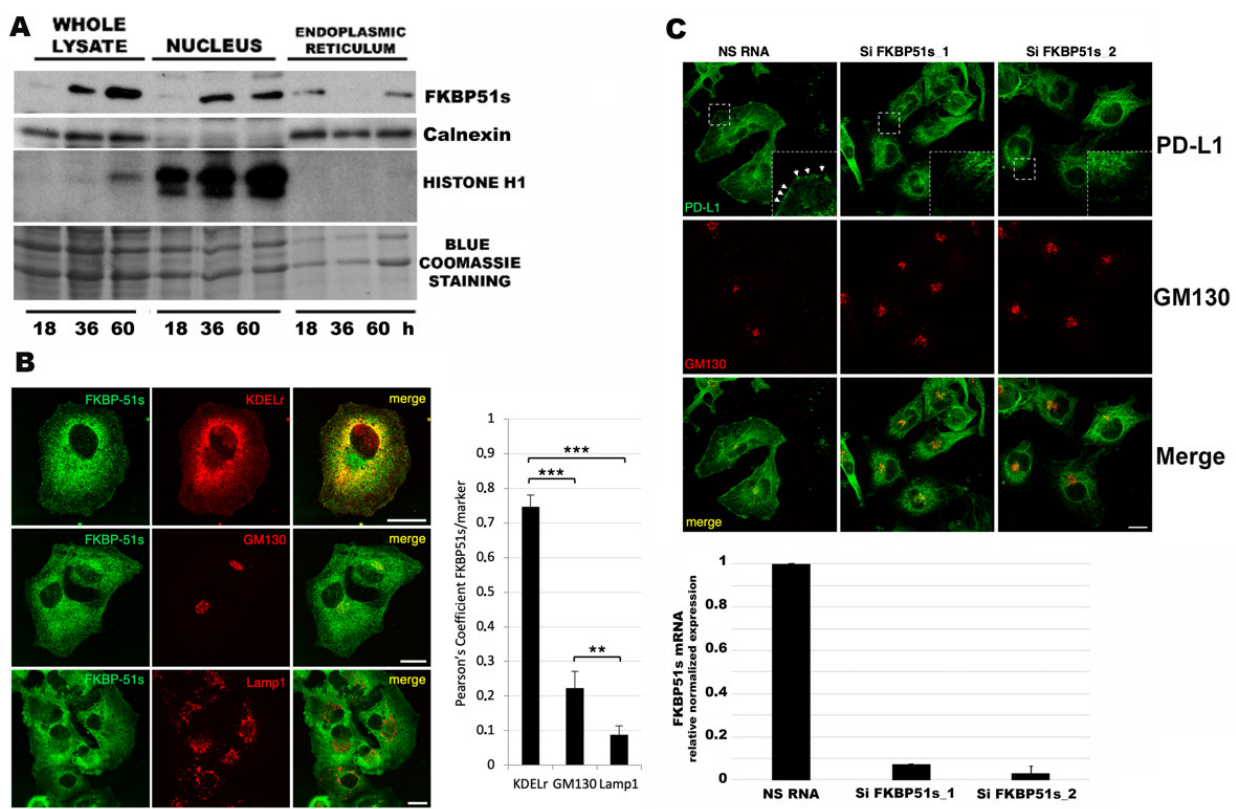
Figure 3. FKBP51s cellular distribution. ( A ) Western blot assay of total and fractionated (ER, nucleus) U251MG cell lysates. FKBP51s levels are shown along with relative organelle markers (calnexin, histone H1, for ER and nucleus, respectively) as loading controls. ( B ) Confocal microscopy: U251MG cells were seeded on coverslips and after 24 h were processed for indirect immunofluorescence by using specific antibodies against FKBP51s, KDEL receptor (ER marker), GM130 (Golgi marker), and Lamp1 (Lysosome marker). The histogram on the right indicates the colocalization (expressed with Pearson’s Coefficient) of FKBP51s with different markers of the intracellular compartments. Scale bar, 50 um. Data are mean ± SD (N = 3), ** p < 0.01, *** p < 0.001. ( C ) Twenty-four h after transfection with NS RNA or SiFKBP51s, U251MG cells (seeded on coverslips) were handled as in B immunofluorescence by using specific antibodies against GM130 (Golgi marker) and PD-L1 (Upper). Zoomed cropped insets are shown in the dashed white squares. White arrows indicate the plasma membrane localization of PD-L1. Single focal sections are shown. Scale bar, 50 um. Analysis by qPCR of FKBP51s transcript levels in U251 transfected cells (relative normalized expression, NS RNA reference sample) is also shown (Lower). Data are mean ± SD (N =